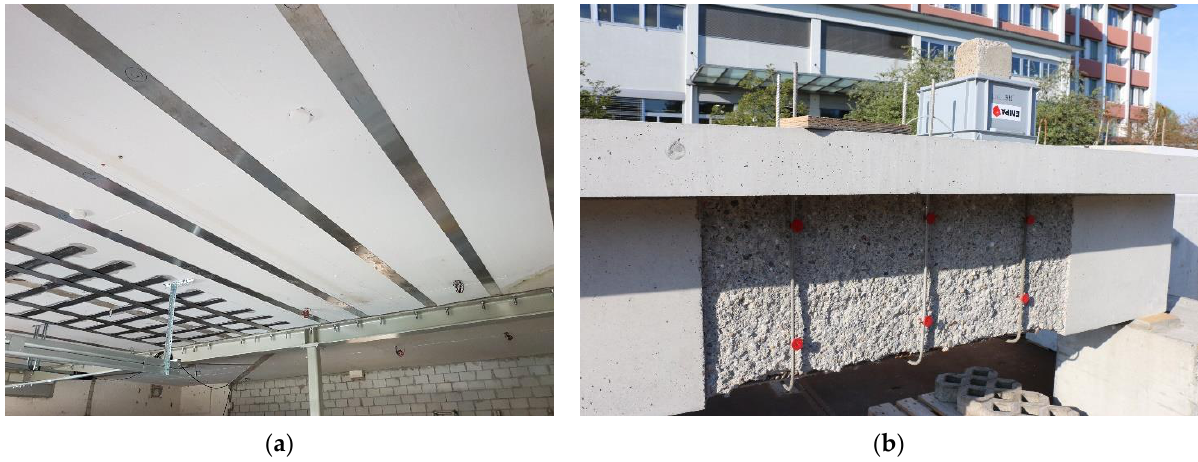
Figure 1. Application of FeMnSi-SMAs in civil engineering: ( a ) an example of FeMnSi-SMA strips used as a flexural strengthening of a reinforced concrete slab. ( b ) FeMnSi-SMA bars applied to improve the shear carrying capacity of a RC beam.